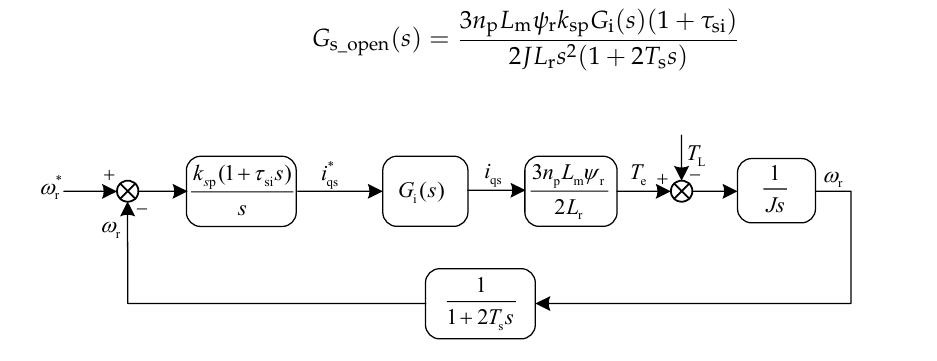
Figure 14. The control diagram of the speed loop.